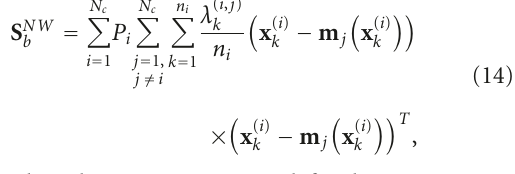
associated with training samples, to maximize the separa- blility between di ff erent categories in a projection subspace.